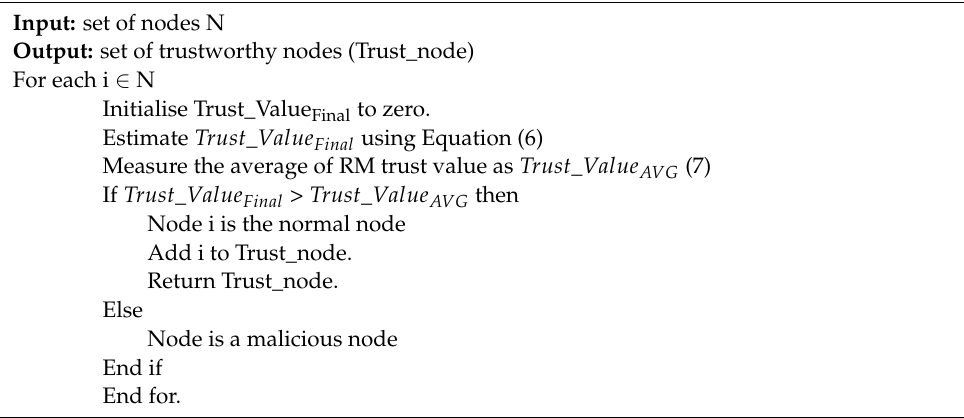
Algorithm 1 Weight-Based Trust Estimation (WBTE) Algorithm